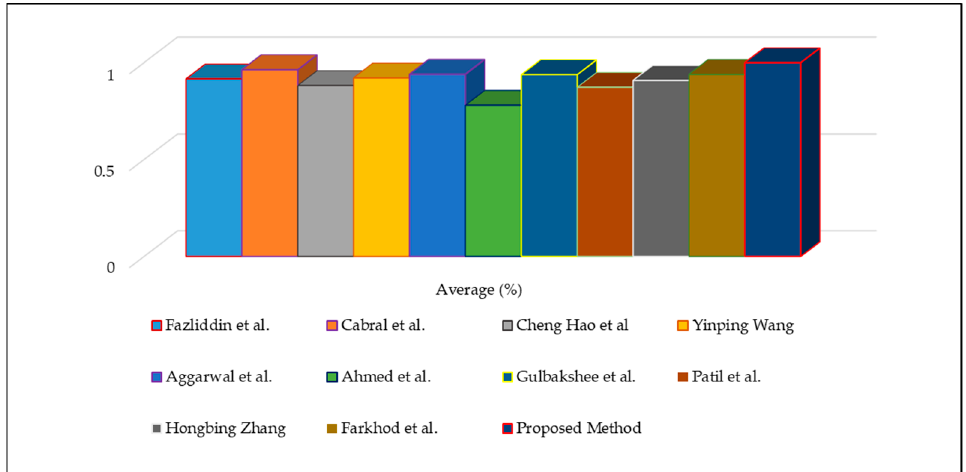
Figure 11. Quantitative results of speech signal feature extraction approaches using vertical graphs.